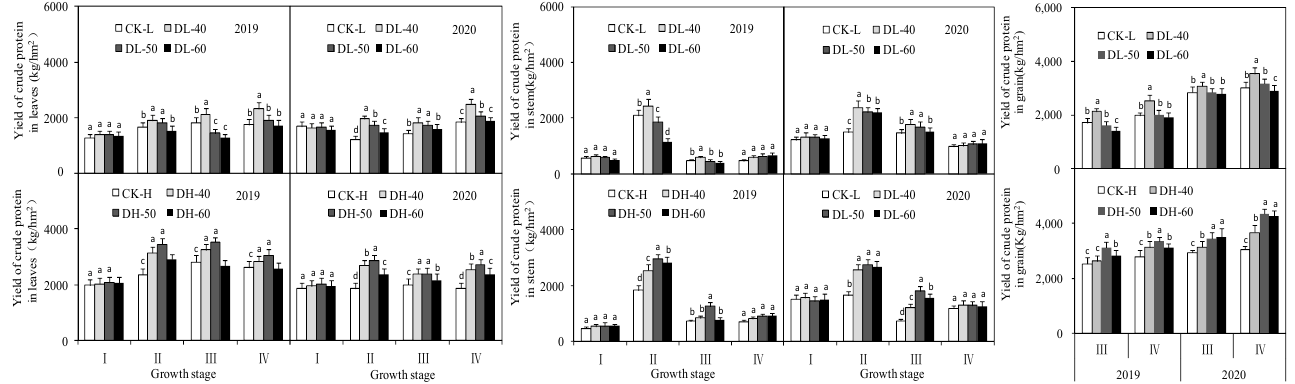
Figure 8. Effects of density and fertilization on the crude protein yield in organs of forage maize. Note: Different letters on bars indicate significant differences among treatments at the 0.05 probability level. Table 1. Average yield of biomass (fresh-weight yield, Kg·hm − 2 ) and the yield component during